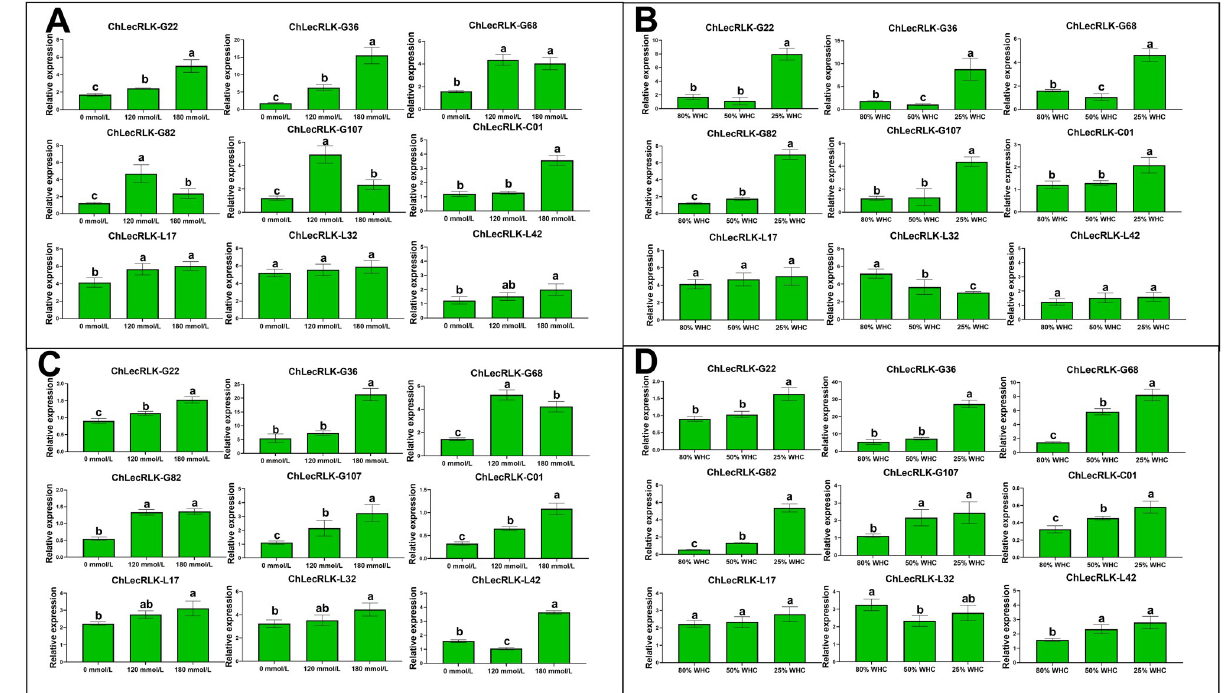
Fig 6. Expression levels of nine members of chLecRLKs in C . humilis . A : Expression in leaves under salt stress; B : Expression in leaves under drought stress; C : Expression in roots under salt stress; D : Expression in leaves under drought stress. WHC represents water holding capacity. Different lowercase letters represent significant difference of chLecRLKs ’ expressions at p <